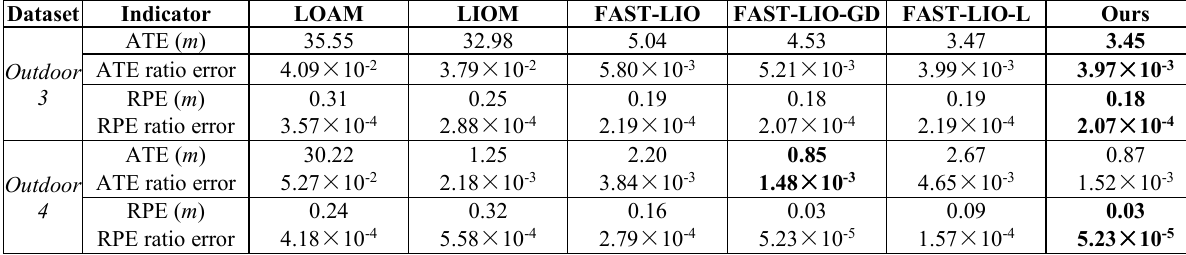
Table 2. Trajectory accuracy evaluation.